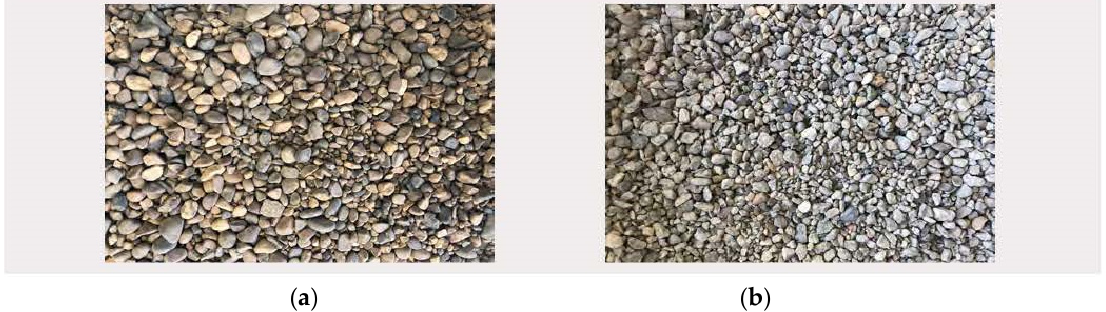
Figure 3. ( a ) Coarse natural aggregates, ( b ) Coarse recycled aggregates.